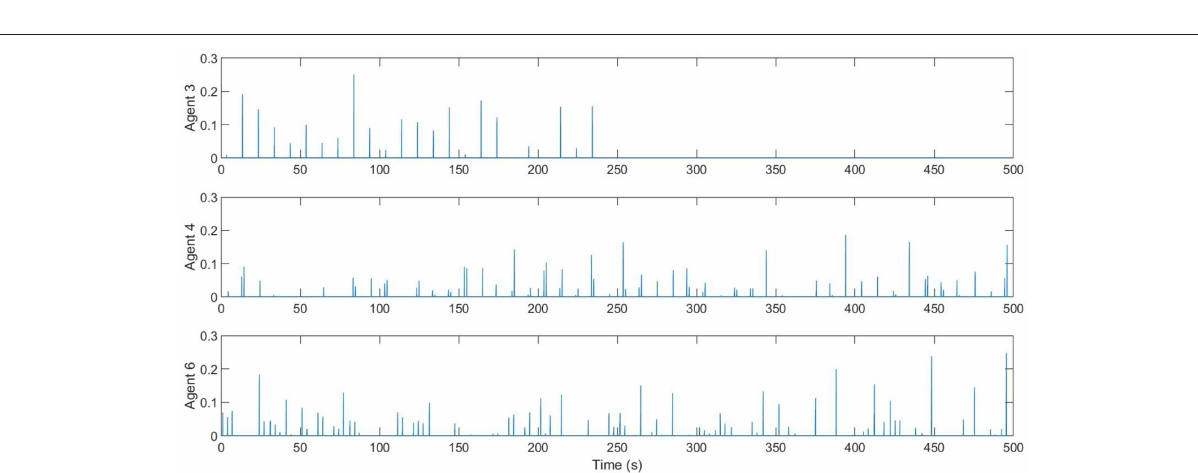
FIGURE 14 | The control input to align an agent’s phases with any companion it is in rendezvous with. Agent 3 failed to rendezvous with any of its neighbors since 240 s, and therefore no control input was generated after that ∼